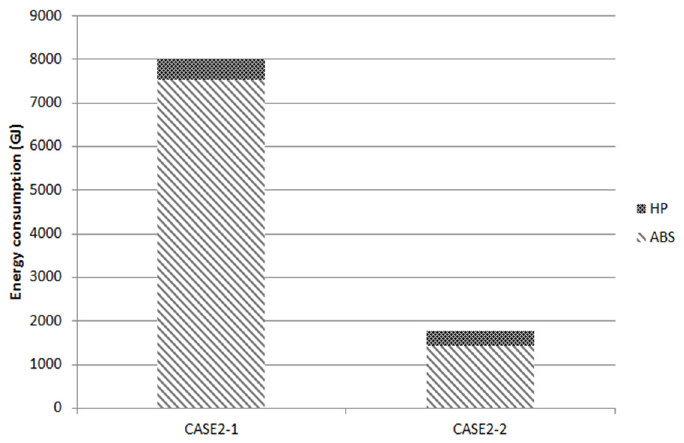
Figure 19. Comparison of the energy consumption for combination with the Multi-GHP systems and the ABS chiller-heater